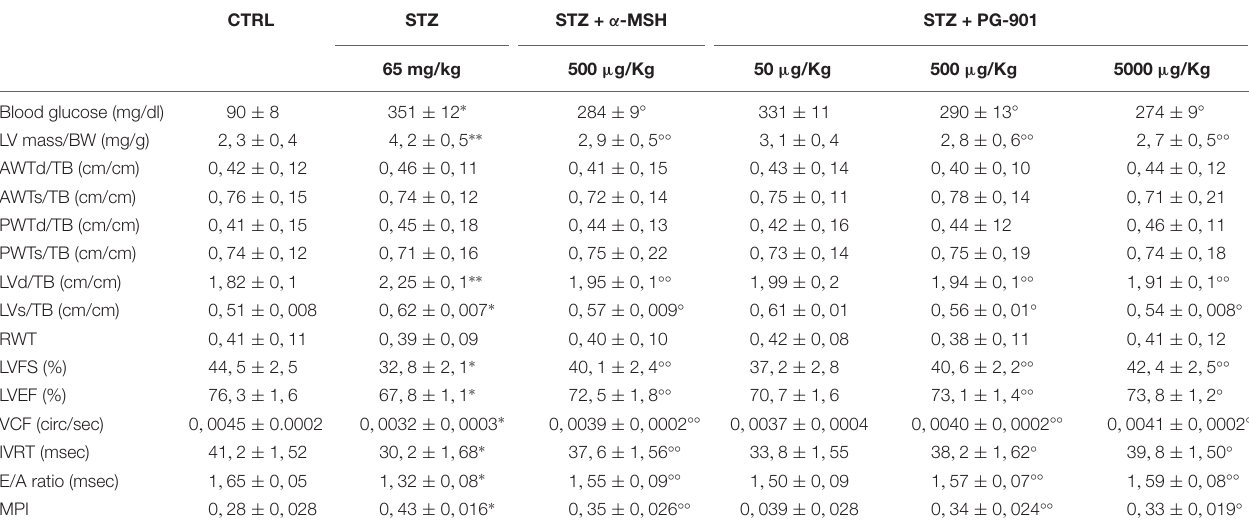
LV mass, left ventricular mass; BW, body weight; AWTd, anterior wall thickness in diastole; TB, tibial length; AWTs, anterior wall thickness in systole; PWTd, posterior wall thickness in diastole; PWTs, posterior wall thickness in systole; LVd, left ventricular internal dimensions in diastole; LVs, left ventricular internal dimensions in systole; RWT, relative wall thickness; LVFS, left ventricular fractional shortening; LVEF, left ventricular ejection fraction; VCF, left ventricular circumferential fiber shortening; IRVT, isovolumetric relaxation time; E/A ratio, ratio of maximal early diastolic peak velocity / late peak velocity of mitral flow; MPI, myocardial performance index. Values are expressed as mean ± S.E.M. of n = 5 animals; for each rat the average was obtained from three consecutive cardiac cycles. CTRL, non-diabetic rats; STZ, diabetic rats; ∗∗ P < 0,05 and ∗ P < 0,01 vs. CTRL; ◦◦ P < 0,01 and ◦ P < 0,05 vs. STZ.